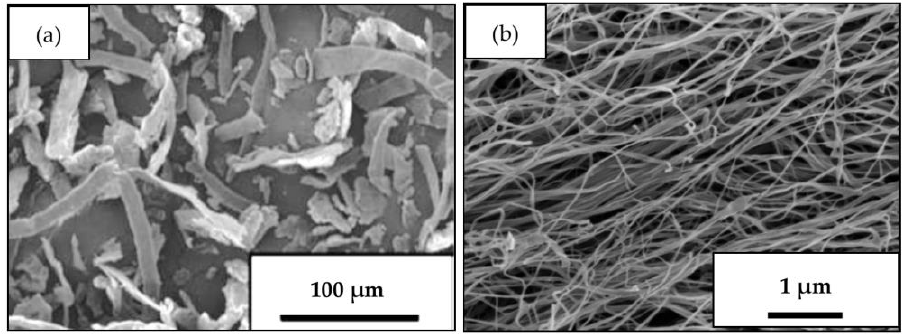
Figure 1. SEM images of microcellulose fibers from eucalyptus pulp ( a ) and nanocellulose fibers 196 from BC ( b ). 197